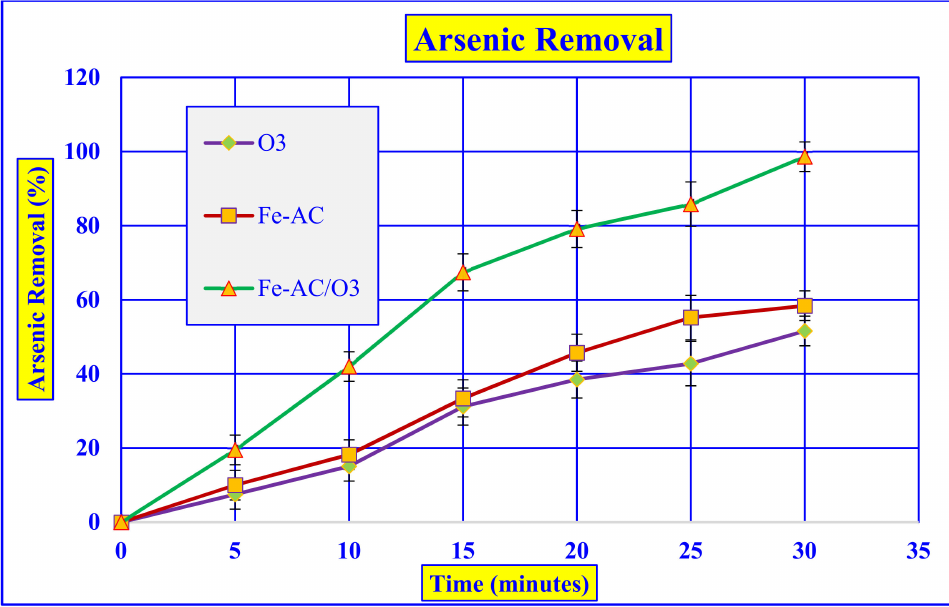
Figure 2. Arsenic removal in adsorption, single ozonation, and catalytic ozonation processes (As = 75 µ g/L; O 3 = 1.0 mg/min, O 3 /Fe-AC = 10 g/L, pH = 7.6 ± 0.2; t = 30 min; volume = 1 L, T = 25 ± 2 ◦